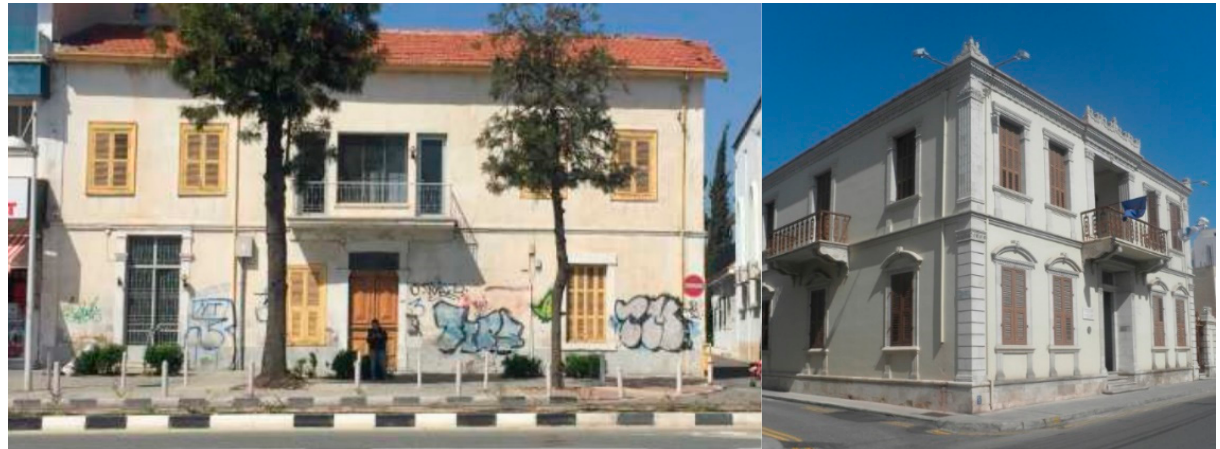
Figure 3. Examples of historic buildings in Limassol, investigated under the Periscope project (photograph sources: Municipality of Limassol©).